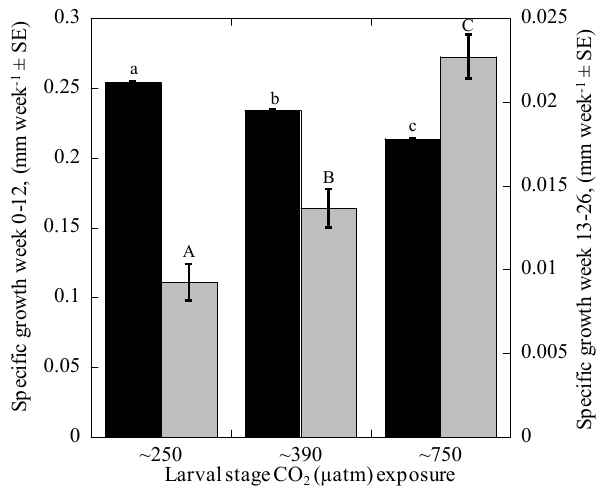
Fig. 6. Specific growth rates of Argopecten irradians for 0–12 Figure 6. Specific growth rates of Argopecten irradians for 0-12 weeks (black bars) and 988 weeks (black bars) and for 13–26 weeks (gray bars). Larvae for 13-26 weeks (gray bars). Larvae ( n = 1000) were grown under three CO 2 989 concentrations (250, 390, and 750 µatm CO 2 ; Table 6) during the larval stages before 990 ( n = 1000) were grown under three CO 2 concentrations (250, 390, introduced into the field as juveniles. For Tukey multiple comparisons, p ≤ 0.05 for all 991 and 750µatm CO 2 ; Table 6) during the larval stages before intro- and capitalized letters indicate a separate analysis. 992 duced into the field as juveniles. For Tukey multiple comparisons, 993 p ≤ 0 . 05 for all. Capitalized letters indicate a separate analysis.